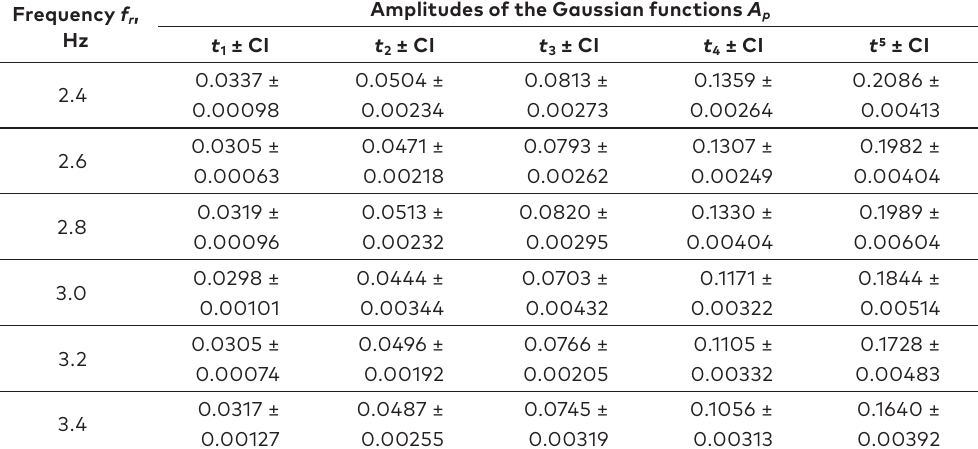
Table 11. Examples of t p mean values and 95% confidence intervals (CI) determined for one heel-strike pattern runner in frequency